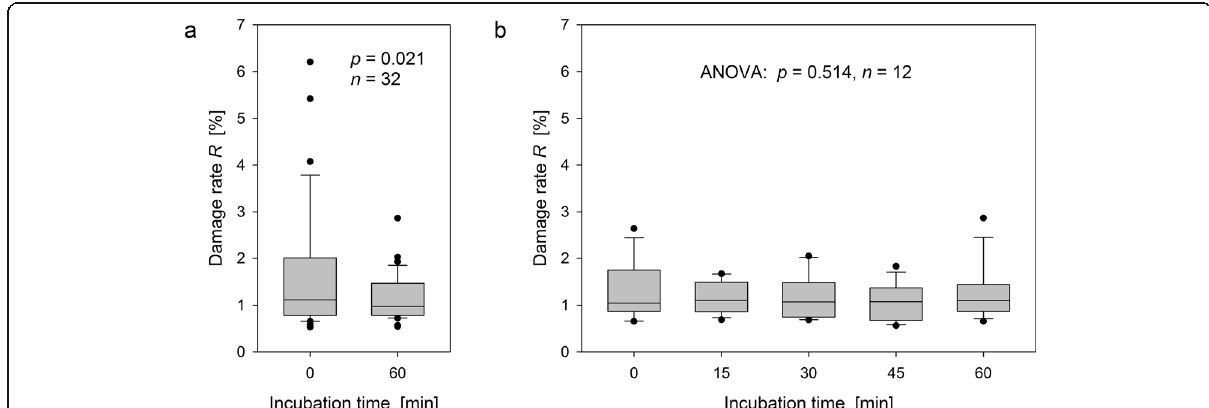
Fig. 5 Impact of incubation per se on damage rates of lymphocytes fixed and isolated from blood samples taken ( a ) from all volunteers at sampling point SP1 that were subsequently incubated up to 60 min (Wilcoxon test) and ( b ) from 12 volunteers of SA2 at sampling point SP3 that were subsequently incubated up to 60 min (Friedmann test). The lower and the upper boundary of the boxes indicate the 25th and the 75th percentiles, the solid horizontal lines in the boxes the median, and the whiskers the 10th and the 90th percentiles. Outliers are represented by dots